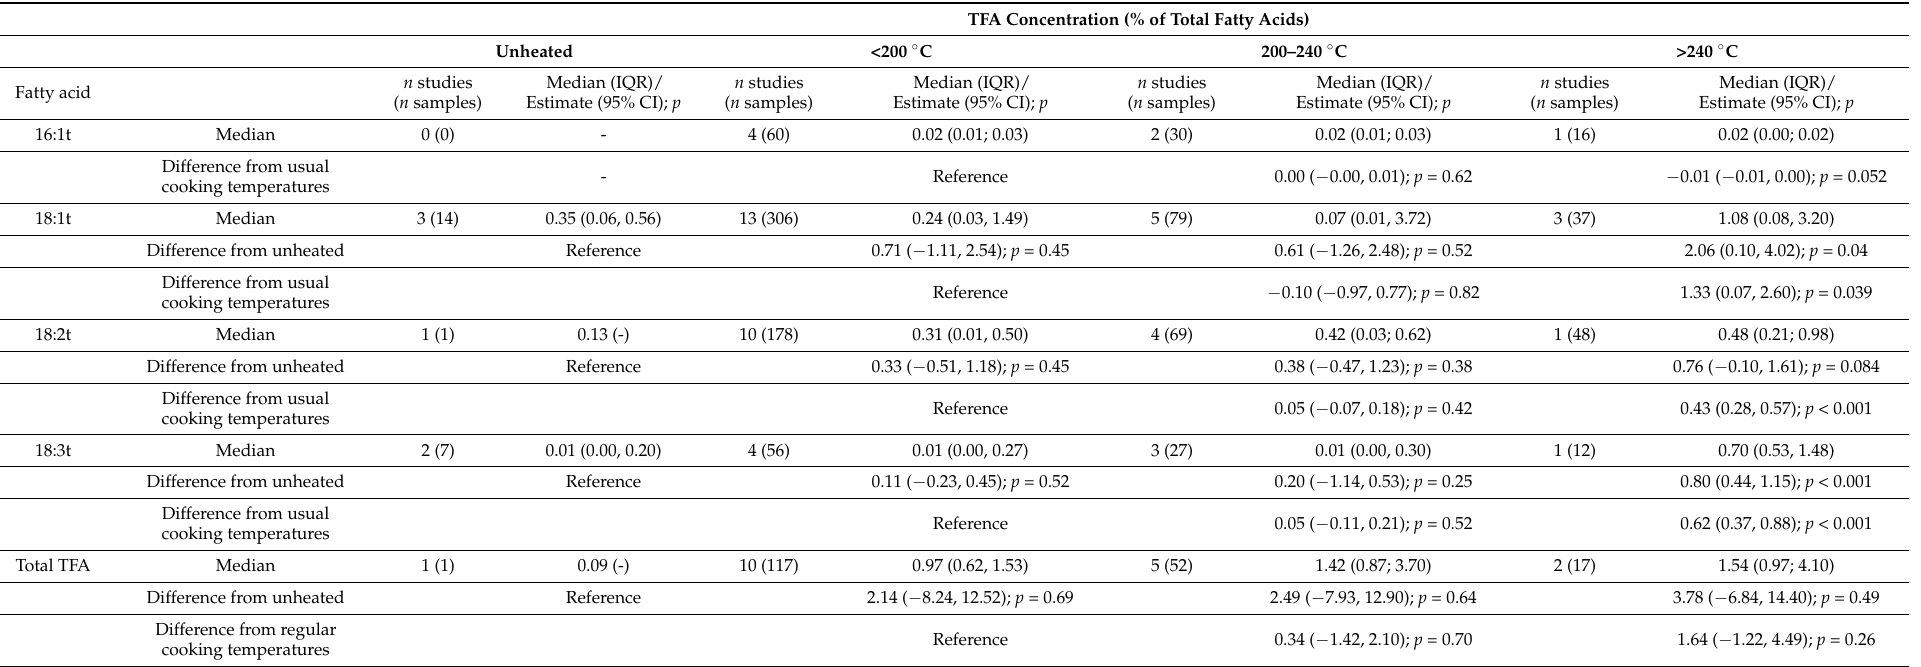
Table 1. Levels of different trans fatty acid (TFA) (% of total fatty acids) as a function of heating temperature. Changes in TFA levels resulting from heating oils above room temperature as well as the difference in TFA levels in oils heated to high (>200 ◦ C) versus usual cooking temperatures ( ≤ 200 ◦ C) are depicted for each TFA